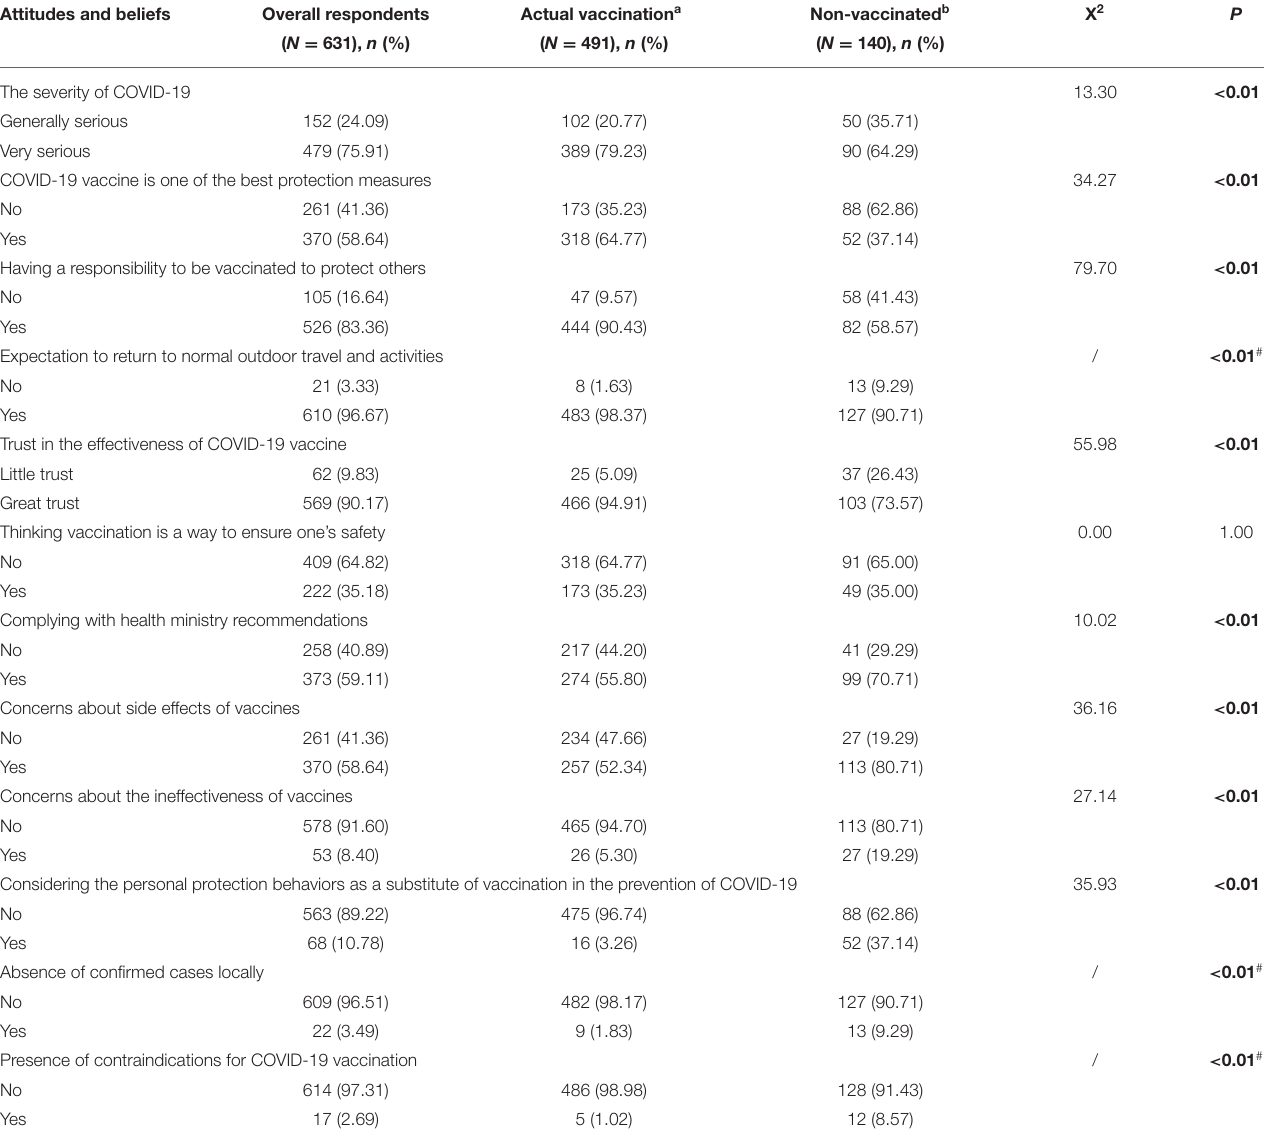
TABLE 2 | Participants’ attitudes and beliefs toward COVID-19